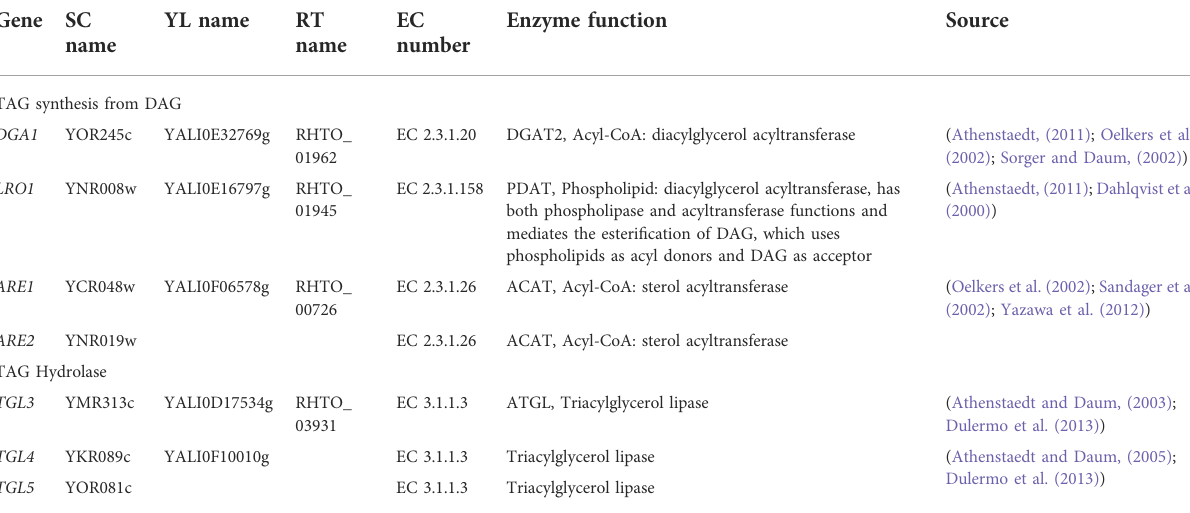
TABLE 2 TAG synthesis from DAG and hydrolysis-related enzymes in S. cerevisiae (SC), Y. lipolytica (YL), and R. toruloides (RT)